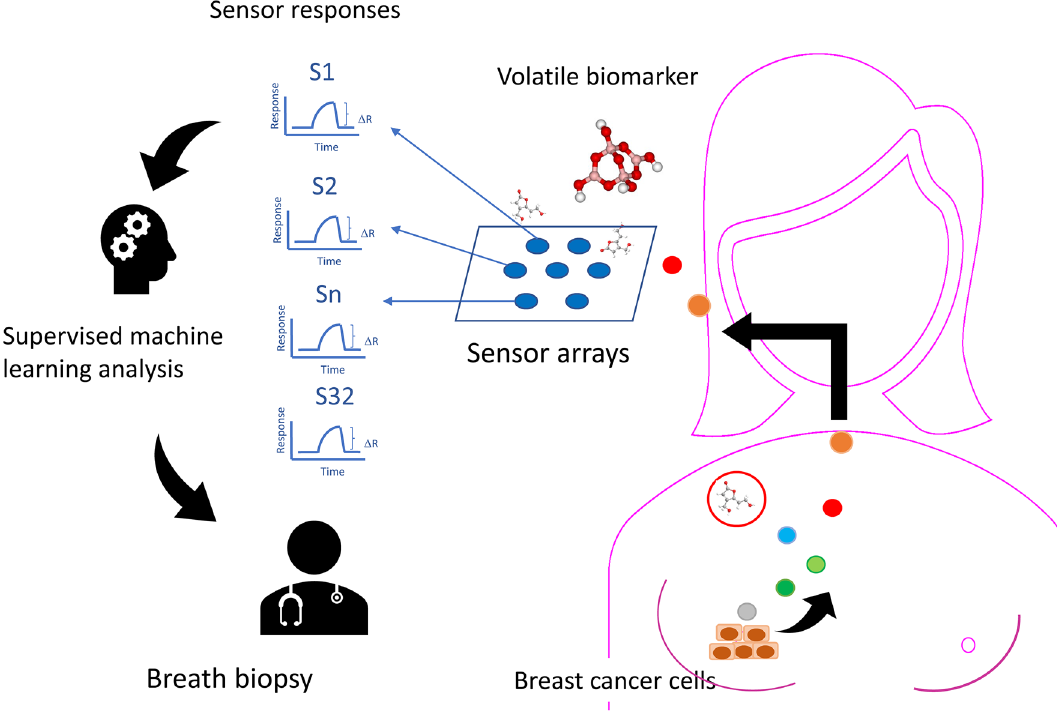
Figure 1. Graphical abstract showing the principle of breath biopsy. Legends: Volatile metabolites produced by breast cancer cells circulate to the lungs and are released into the breath. Using the sensor array to